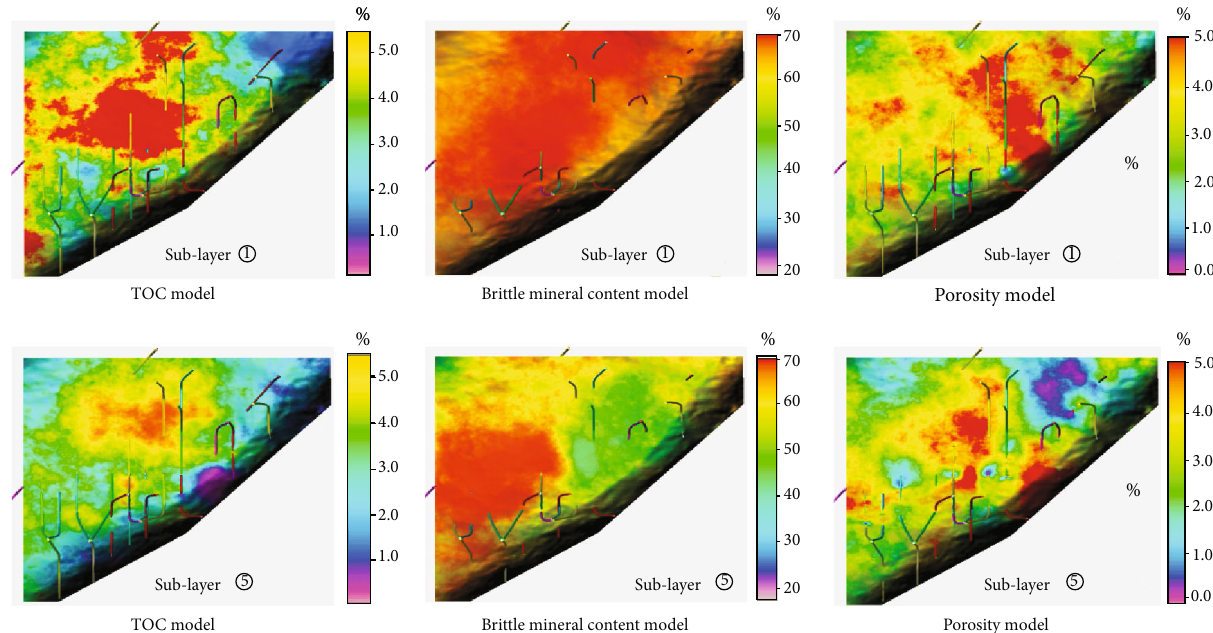
Figure 11: Shale reservoir property models in the study area. The fi gure shows the spatial distribution and interconstraint relationship of TOC, brittle mineral content, and porosity for two lithofacies